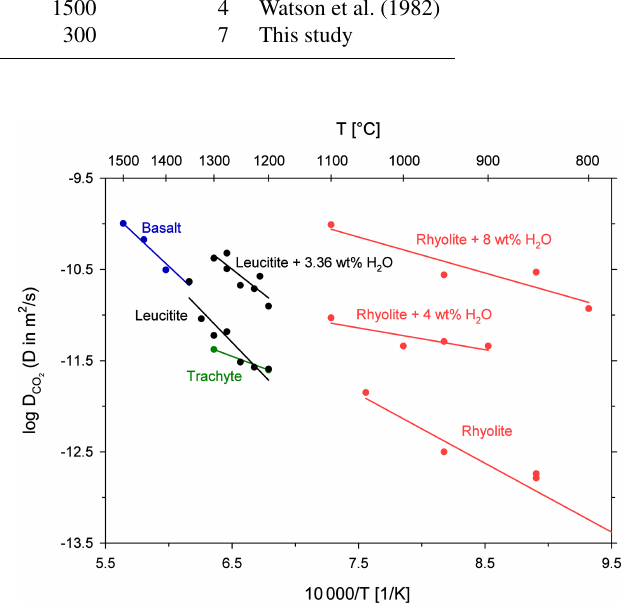
Table 6. CO 2 activation energies for different anhydrous silicate melts. Melt Rhyolitic Basaltic Leucititic